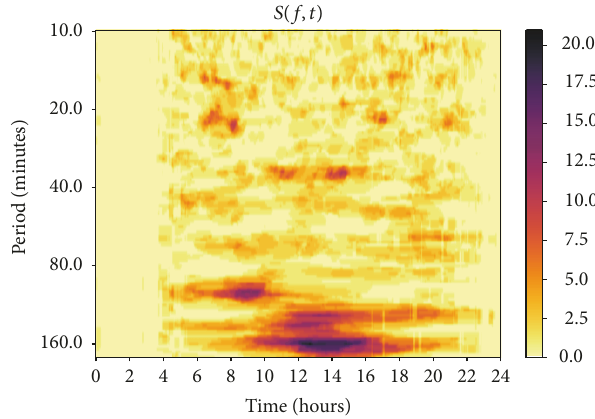
Figure 1: Phase-locking statistics. Sum of the number of phase- locking links between all cities 𝑆(𝑓,𝑡) for May 27. The horizontal axis represents a temporal span of instants 𝑡 during the day, and the vertical axis represents the period corresponding to the frequency 𝑓 of the wavelets used for extracting phase contents of the signals. The colour represents the sum of phase-locking links for 𝑓 and 𝑡